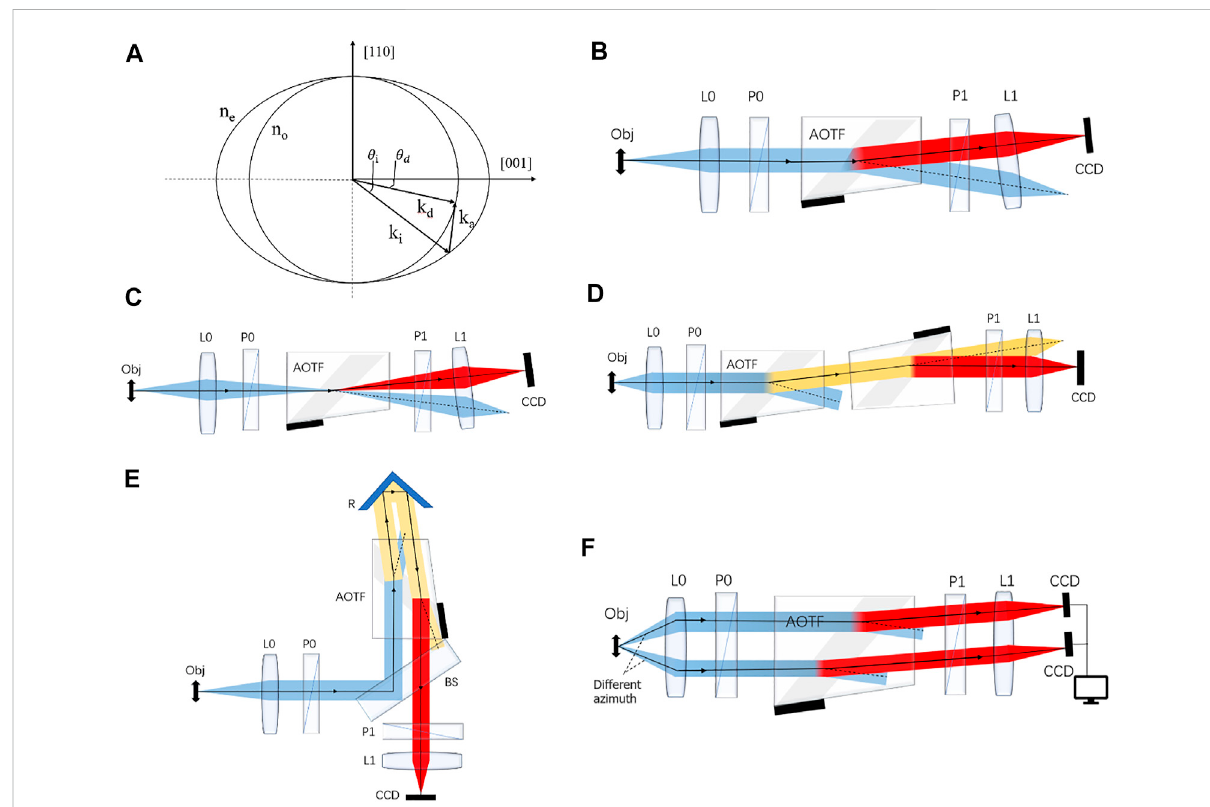
FIGURE 1 (A) Non-collinear acousto-optic interaction wave vector diagram in TeO 2 , (B) collimating scheme, (C) confocal scheme, (D) tandem scheme, (E) double-pass single-crystal AOTF based spectral scheme, (F) double-path scheme (Obj, object; L, lens; P, polarizer; R, retrore fl ector; BS, beam splitter; CCD, charge-coupled